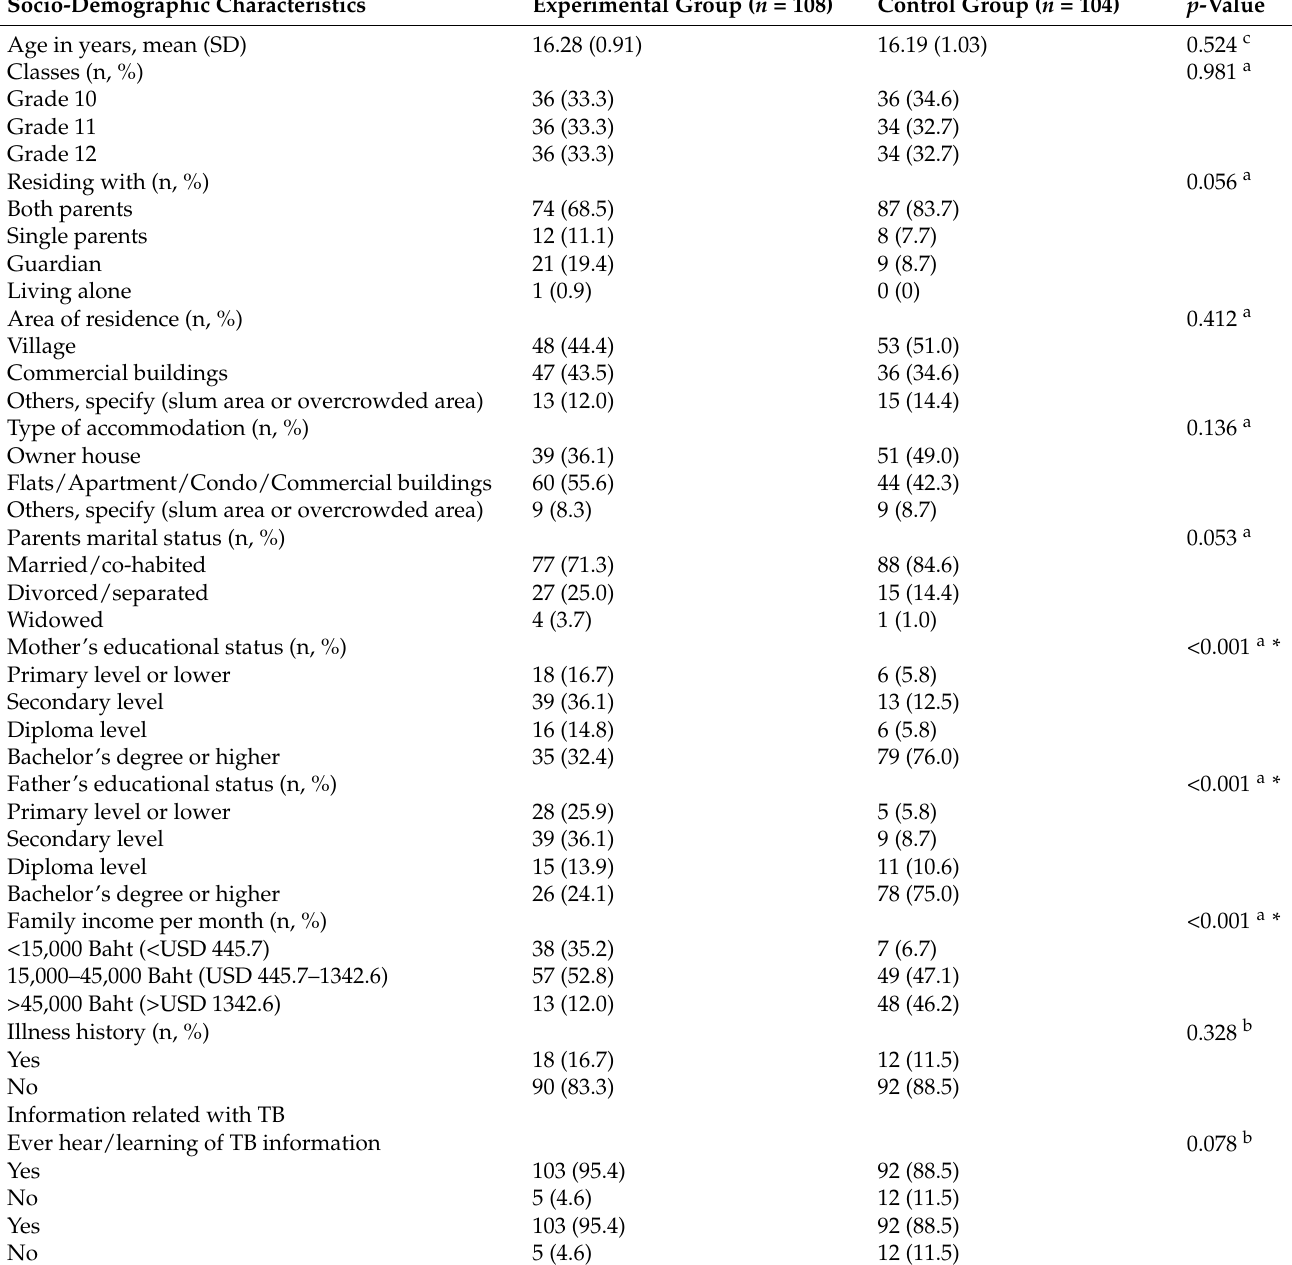
Table 1. Baseline socio-demographic characteristics of the participants. ( n =